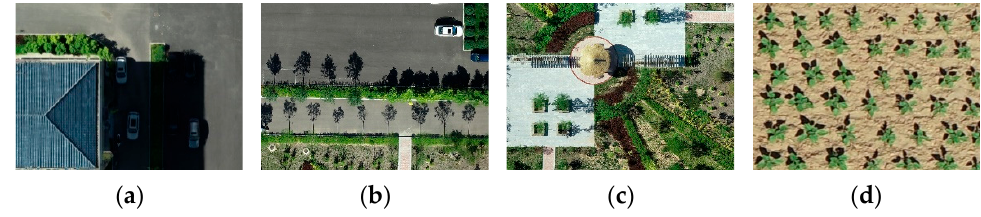
Figure 4. UAV RGB images: ( a ) study case 1; ( b ) study case 2; ( c ) study case 3; ( d ) study case 4.